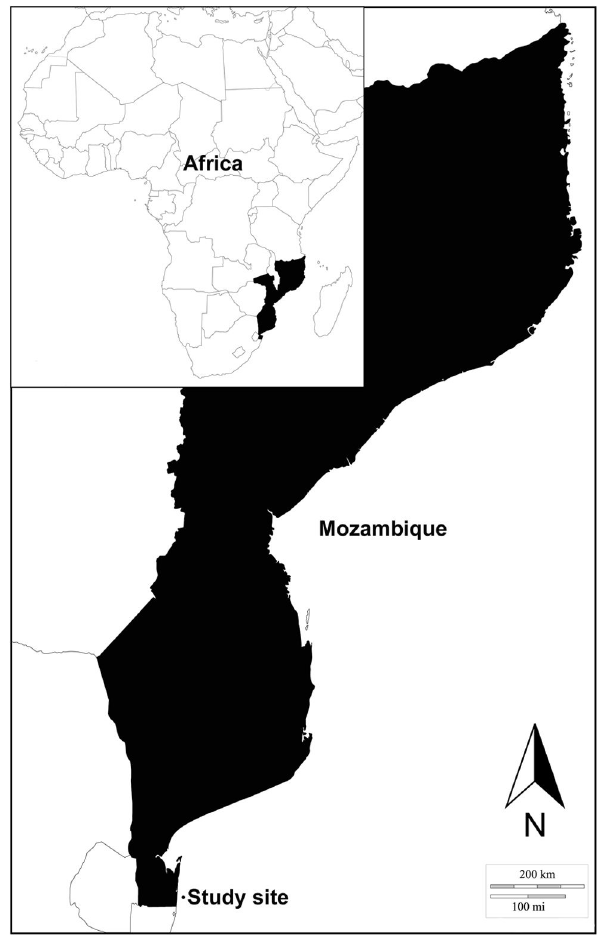
Figure 1. The study site is located in the southwest Indian Ocean off the coast of southern Mozambique within the Ponta do Ouro Partial Marine